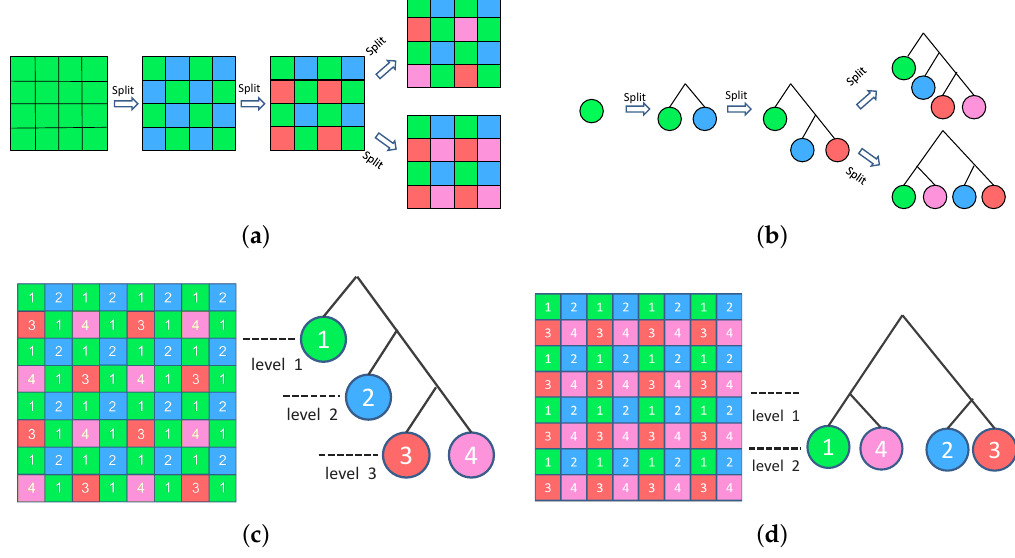
Figure 4. ( a ) Generation of the MSFAs. ( b ) Generation of the binary trees. ( c , d ) Left: two patterns of four channels MSFA; right: the binary trees of the four channels pattern have four leaves, each leaf represents a spectral channel. The four leaf nodes correspond to the four spectral channels with ( c ) sampling rate { 1 , 1 , 1 , 1 } and ( d ) sampling rate { 1 2 8 8 4